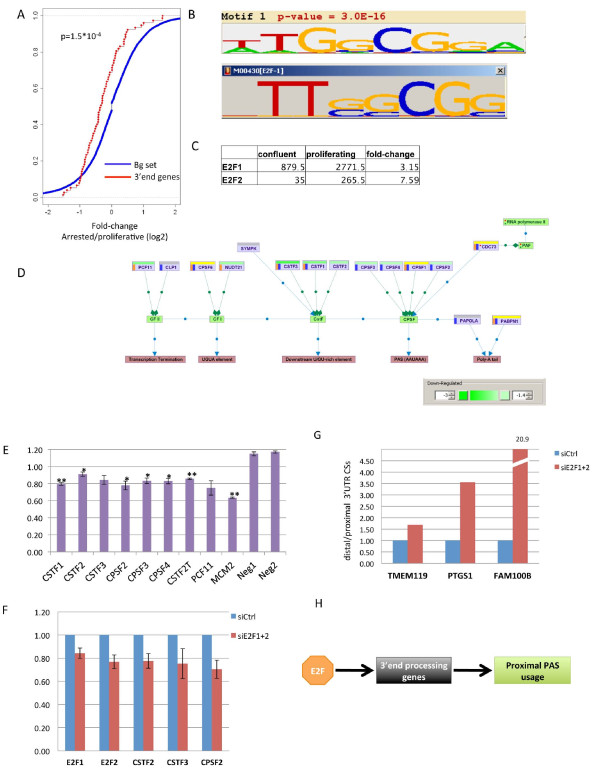
E2F-mediated regulation of APA in proliferation. (a) Comparison of the distribution of fold-change (in log2) in expression levels between confluent and proliferative cells calculated over two sets of genes: a target set that contained the 3'-end processing genes and a background set that contained all the rest of genes expressed in BJ cells (P-value calculated using Wilcoxon test). (b) The top scoring motif identified by de novo motif discovery analysis applied to the set of promoters of the 3'-end processing genes matched the binding signature of E2F (motif accession number in TRANSFAC DB: M00430). (c) Normalized expression levels (determined from the 3'-seq data) of E2F1 and E2F2 in proliferating and confluent BJ cells. (d) Schematic map of the core machineries of polyadenylation site recognition and 3'-end cleavage. In this map, nodes correspond to either protein-coding genes (violet nodes) or protein complexes (green nodes), and edges correspond to either regulatory links (blue edges) or association links between complexes and their members (green edges). The fold-change in expression in the transition from proliferating to confluent BJ cells is indicated by the horizontal bar at the top of each node (green corresponds to down-regulation, yellow to no-change and gray to gene not expressed in our dataset). Genes in this network whose promoter was found to be bound by either E2F1 [26] or E2F4 [27] are indicated by an orange and blue vertical bars to their left. (The map was created using the SPIKE knowledgebase of signaling pathways [36].) (e) Effect of knocking down E2F1 on promoter activity of eight 3'-end processing genes assessed using reporter assays. MCM2 served as positive control and an artificial p53 promoter was used as a negative one. *P < 0.05, **P < 0.01. Error bars represent SEM. (f) The effect of knocking down E2F1+2 on the expression levels of three core cleavage factors in BJ cells was examined using qPCR (results shown are mean ± standard deviation based on triplicates in the case of E2F1 and E2F2, and on five replicates for the three cleavage transcripts). In all cases, the reduction in transcript level is statistically significant (P < 0.01; one-tail t-test)). (g) The effect of knocking down E2F1+2 on the relative usage of 3' UTR proximal and distal CSs in three transcripts that showed enhanced usage of the proximal CSs in proliferation was examined using 3'-qPCR (Materials and methods). In all three cases examined, reducing E2F levels increased the relative cleavage at the distal site (namely, reduced the cleavage at the proximal one). Results shown are based on duplicates; in all cases, P < 0.05, one-tail t-test). (h) A schematic model illustrating the E2F-mediated regulation of mRNA 3'end processing enzymes and its effect on APA.